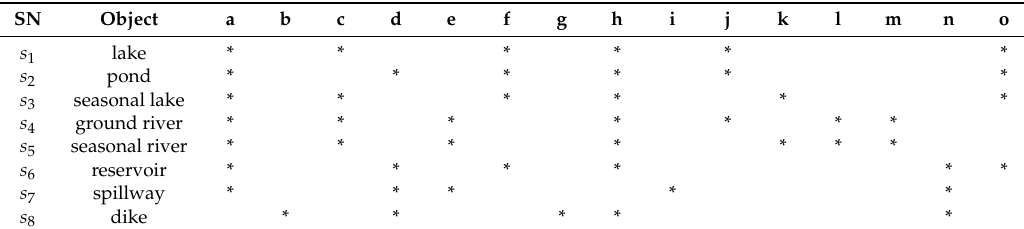
Table 4. A formal context converted from the decision